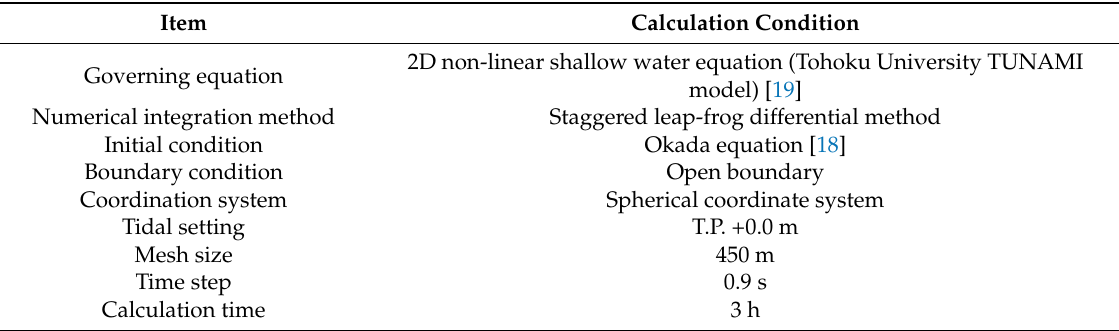
Table 5. Calculation conditions for the tsunami numerical